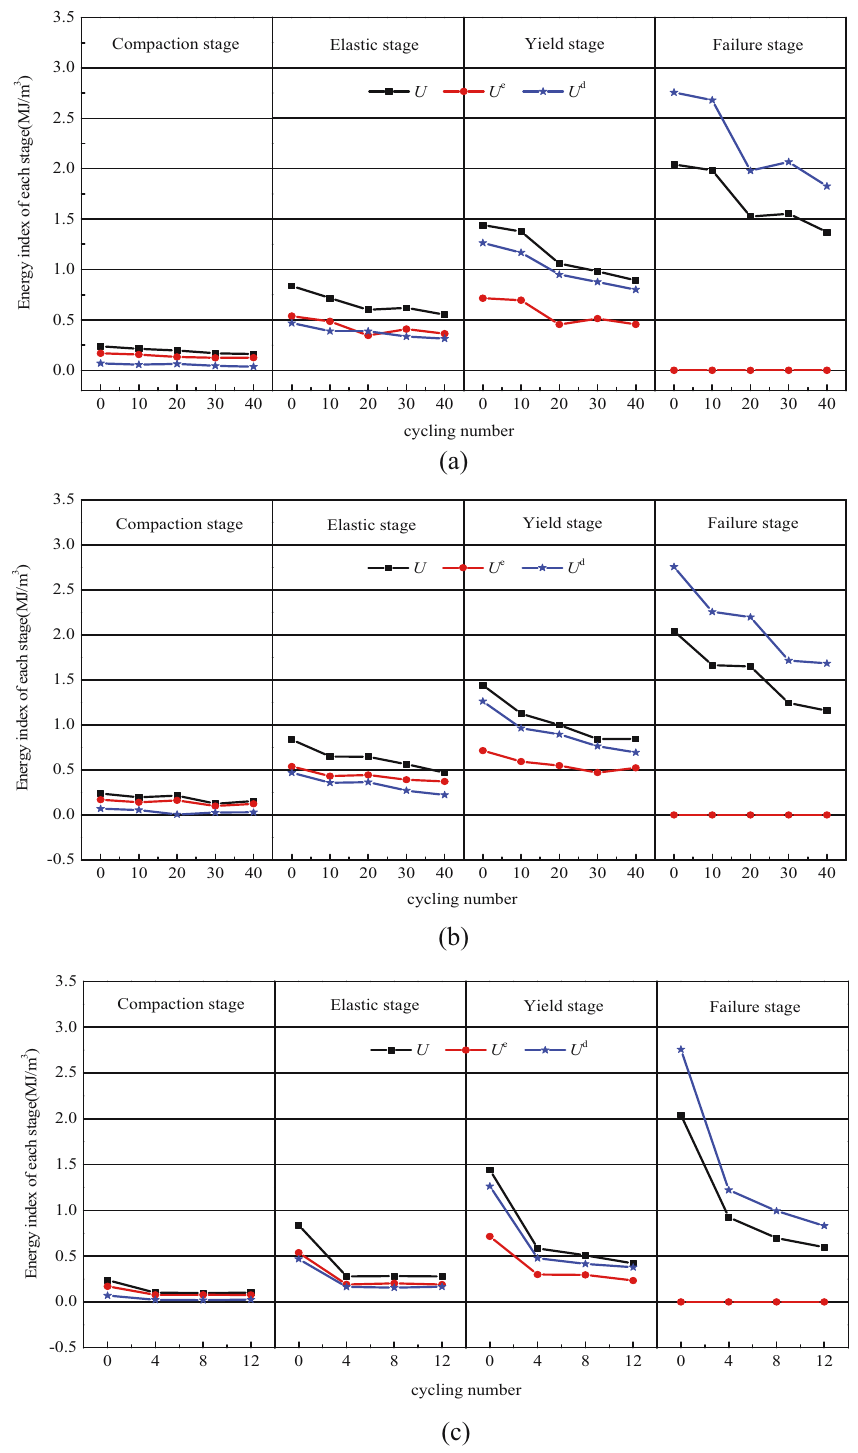
Figure 5: Relationship between energy characteristic index and cycling number in different stages: ( a ) L - T group. ( b ) M - T group. ( c ) H - T